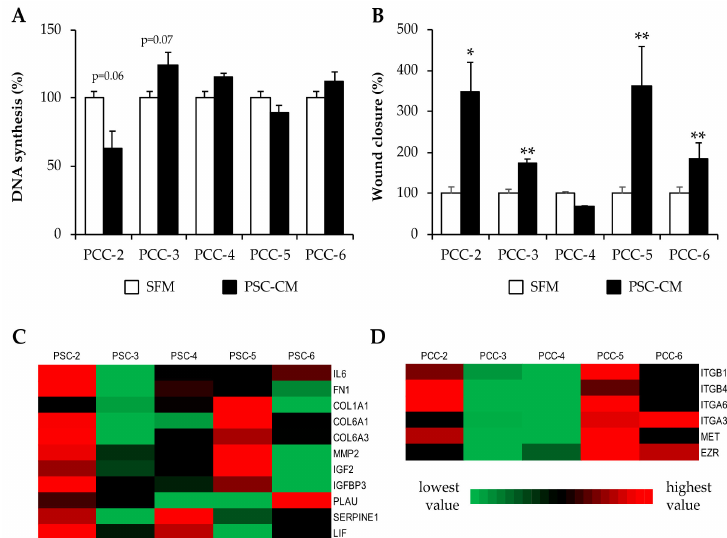
Figure 5. E ff ect of PSC-CM on proliferation and migration of paired PCCs: ( A ) PCCs incubated for 24 h with SFM or paired PSC-CM and DNA synthesis was determined using [ 3 H]-thymidine incorporation assay. ( B ) Scratch wounds were established in PCCs cultured to confluence. Images of the wound area were taken immediately and 24 h after incubation with SFM or PSC-CM. The wound area was measured using FIJI software. Data are mean ± SEM of triplicate ( A ) and 6–12 measurements ( B ). * p < 0.05, ** p < 0.01 comparing SFM (control) vs PSC-CM. ( C , D ) Heatmap showing inter-tumor variability of protein abundance for selected proteins that are proposed to regulate migration of pancreatic cancer cells. Low (green) to high (red) expression pattern was drawn for each individual protein for both PSCs ( C ) and PCCs ( D ). PCC, pancreatic cancer cell; PSC, pancreatic stellate cell; PSC-CM, PSC-conditioned medium; SFM, serum-free